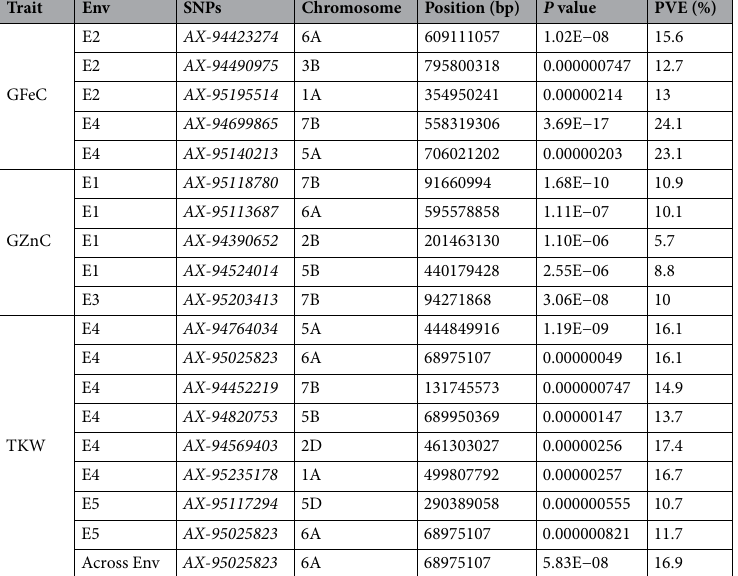
Table 3. MTAs for grain quality traits and TKW identified in the GWAS panel from five environments. Env.: Environment; GFeC: grain iron concentration; GZnC: grian zinc concentration; TKW: thousand kernel weight; E1: Dharwad; E2: IARI Delhi; E3: IARI Jharkhand; E4: Karnal; E5: Ludhiana; SNPs: single nucleotide polymorphisms; PVE: phenotypic variation